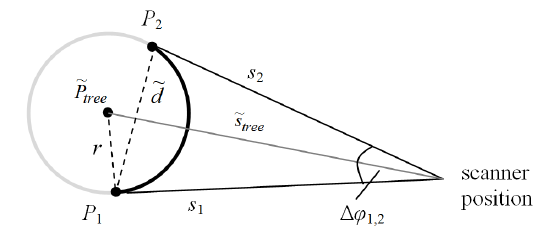
Figure 6. Principle of the determination of the tree position using edge points.